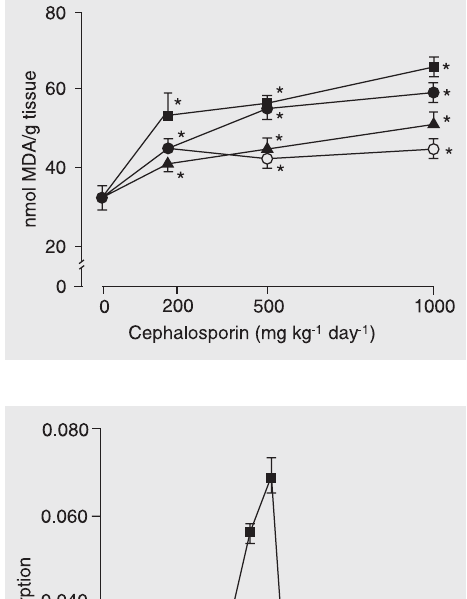
Figure 4. Increase of conjugated diene absorption (concentration) in renal cortical microsomes fol- lowing cephalosporin administra- tion. Rats were given a single ip injection of cephalosporin (2000 mg/kg) and were killed after 18 h. Data are reported as difference in spectrum between values ob- tained from treated animals and values from control rats receiv- ing saline. Squares = cephalori- dine; filled circles = cephalothin; triangles = cefotiam; open circles = cefotaxime. Data are reported as means ± SD for at least 5 rats.